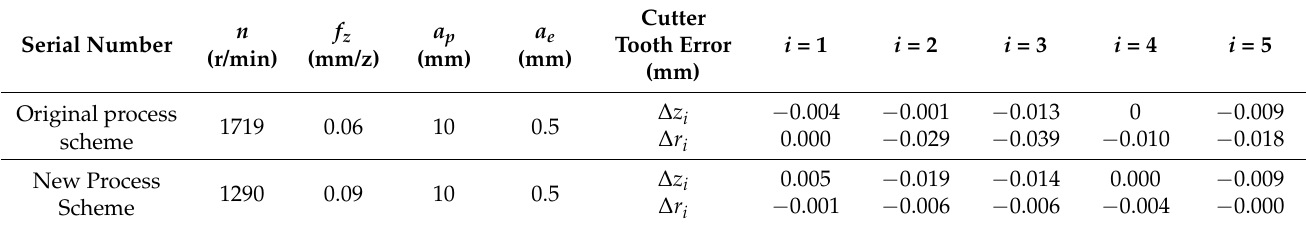
Table 7. Validation of process parameters used in the